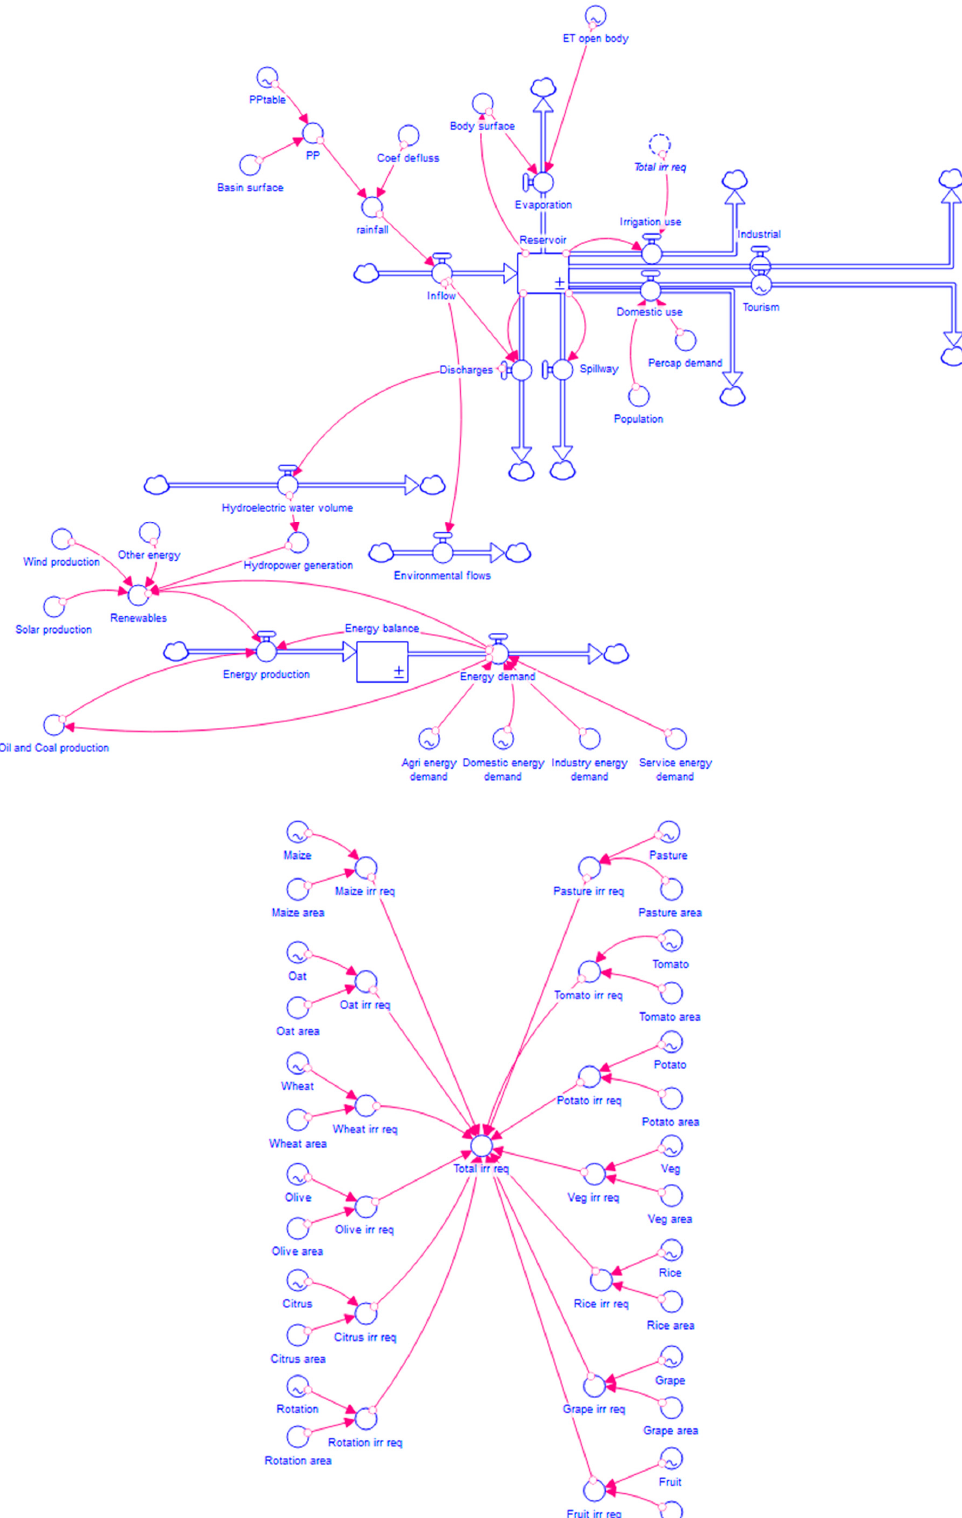
Figure 4. The developed system dynamics model for the Sardinia fast-track.